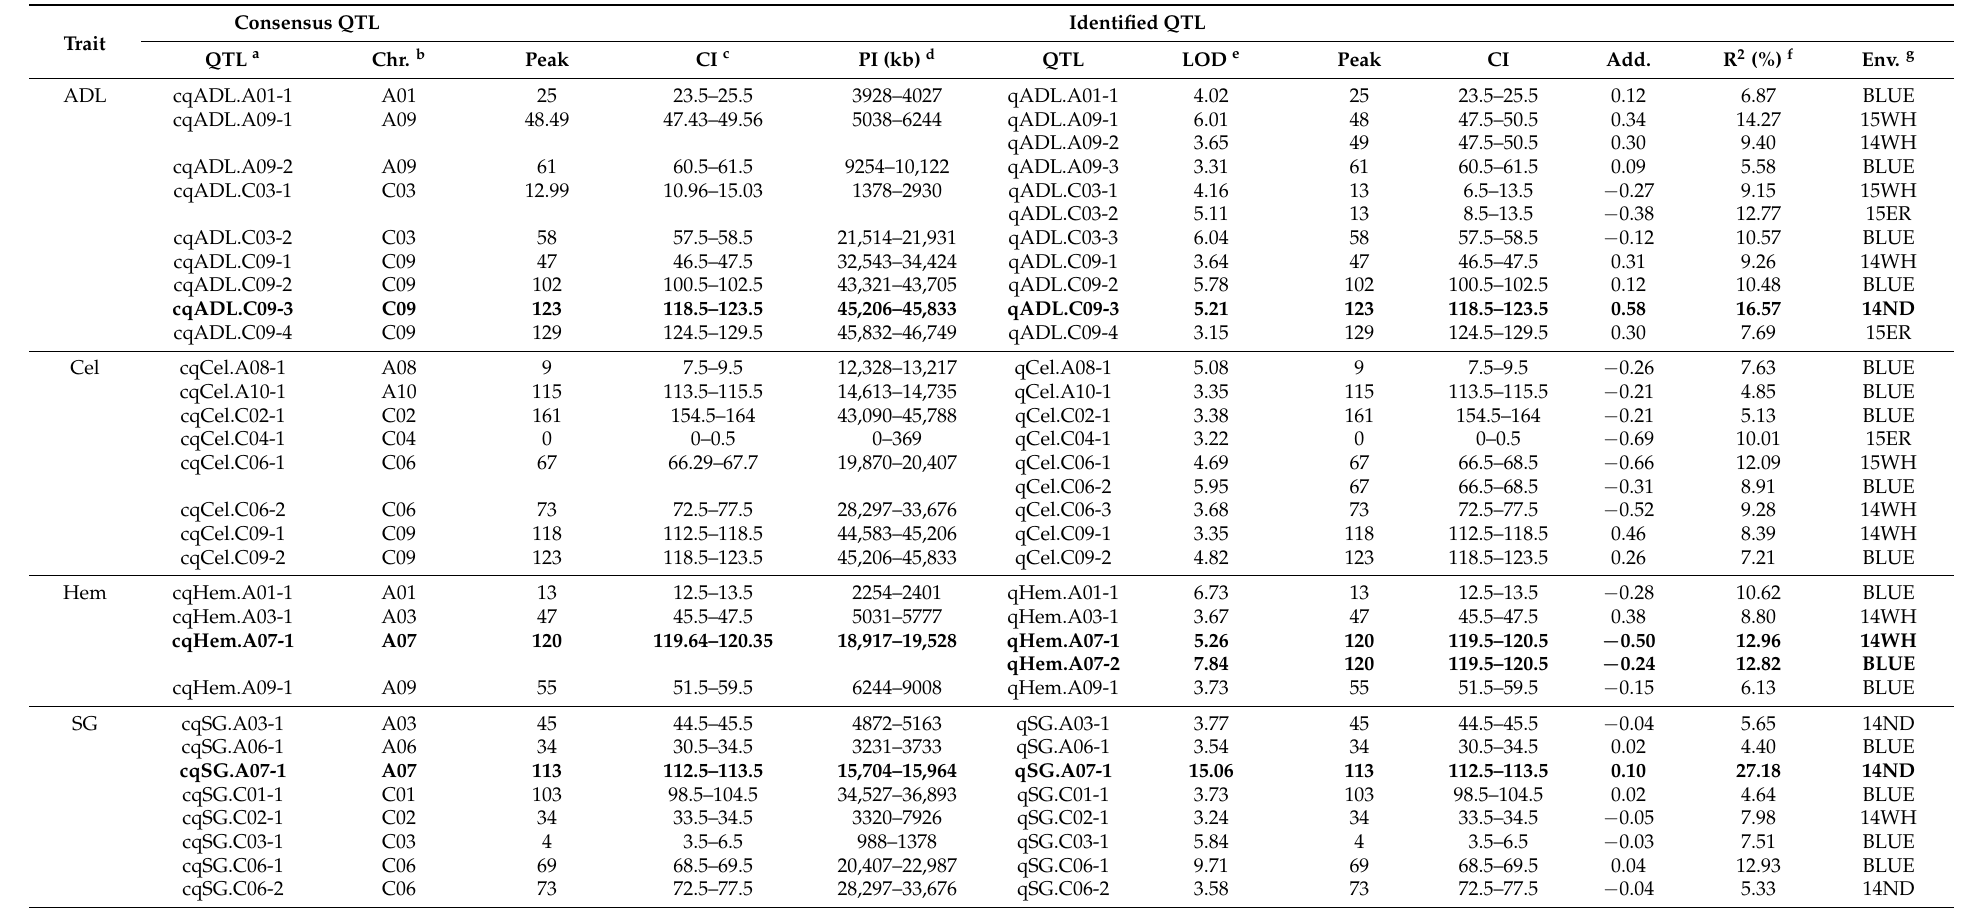
Table 2. Summary of the consensus QTL and their corresponding identified QTL used for QTL